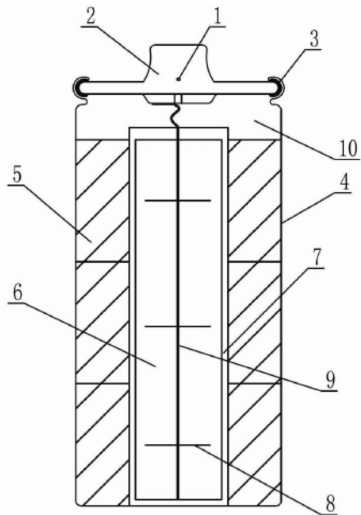
Figure 22. Schematic diagram of a high capacity/non-winding cell with 1: vent hole, 2: cap, 3: sealing ring, 4: can, 5: negative electrode, 6: positive electrode, 7: separator, 8: current collector, 9: tap, and 10: electrolyte [291].